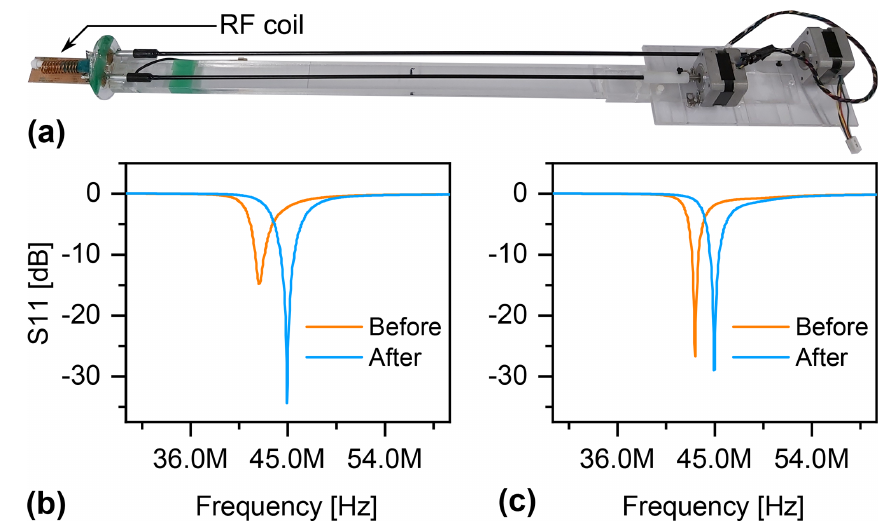
Figure 7. (a) Homemade RF coil with a mechanical setup for automatic T&M. The coil operates at a Larmor frequency of 44.93MHz. (b) Result of applying the ArduiTaM to T&M the coil starting from an arbitrary condition. (c) Result of applying the ArduiTaM to adjust the tuning capacitor only.